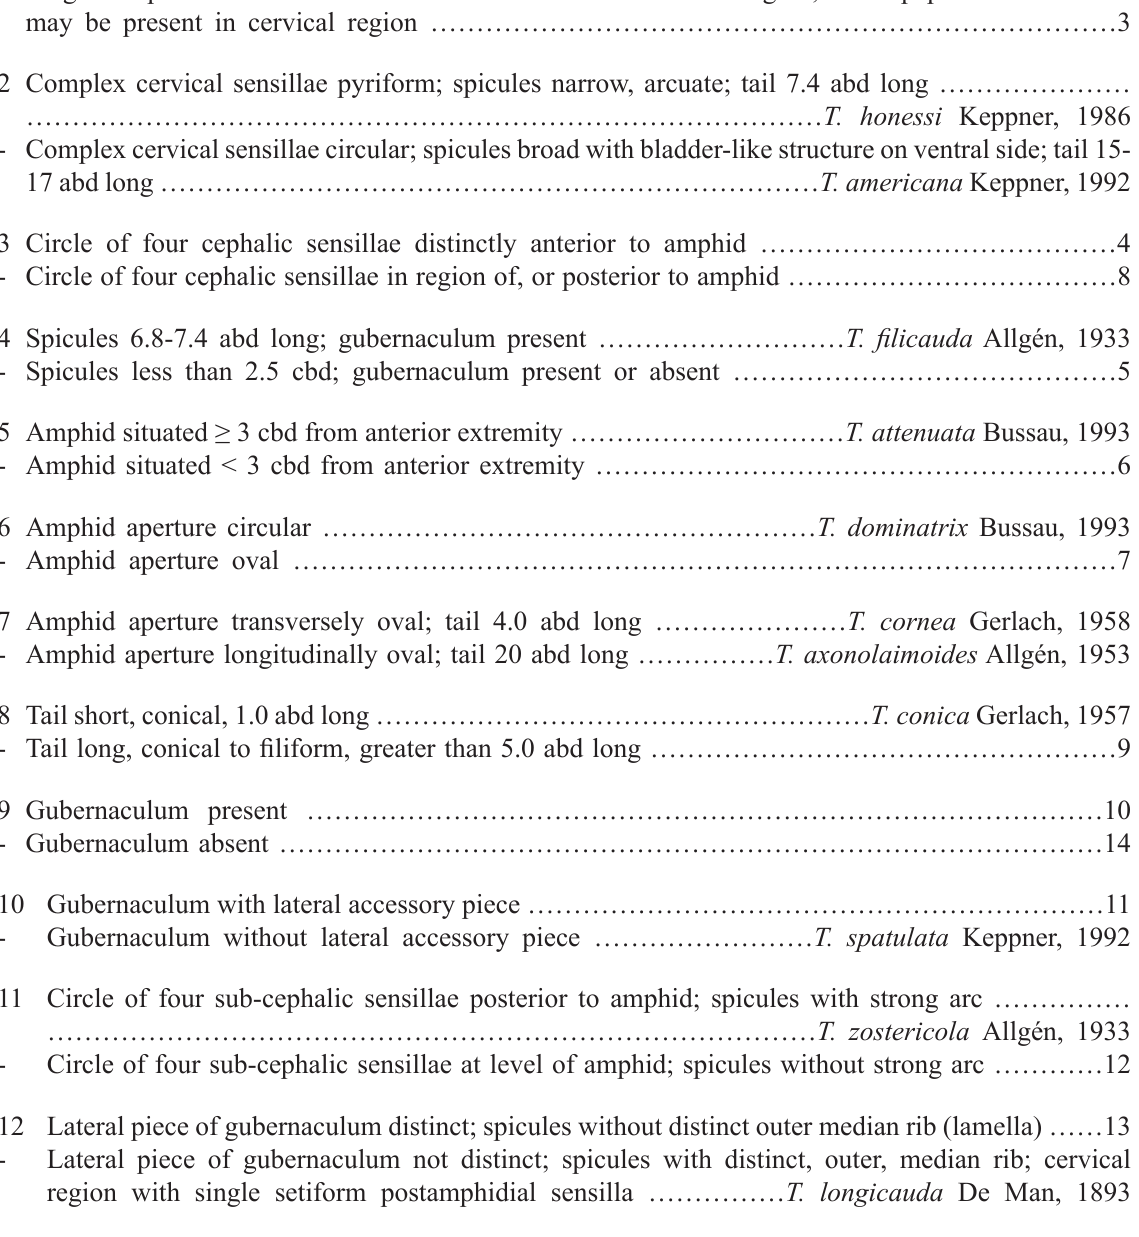
- Large complex sensillae absent on ventral surface in cervical region; small papilliform sensillae 2 complex cervical sensillae pyriform; spicules narrow, arcuate; tail 7.4 abd long ………………… - Complex cervical sensillae circular; spicules broad with bladder-like structure on ventral side; tail 15-